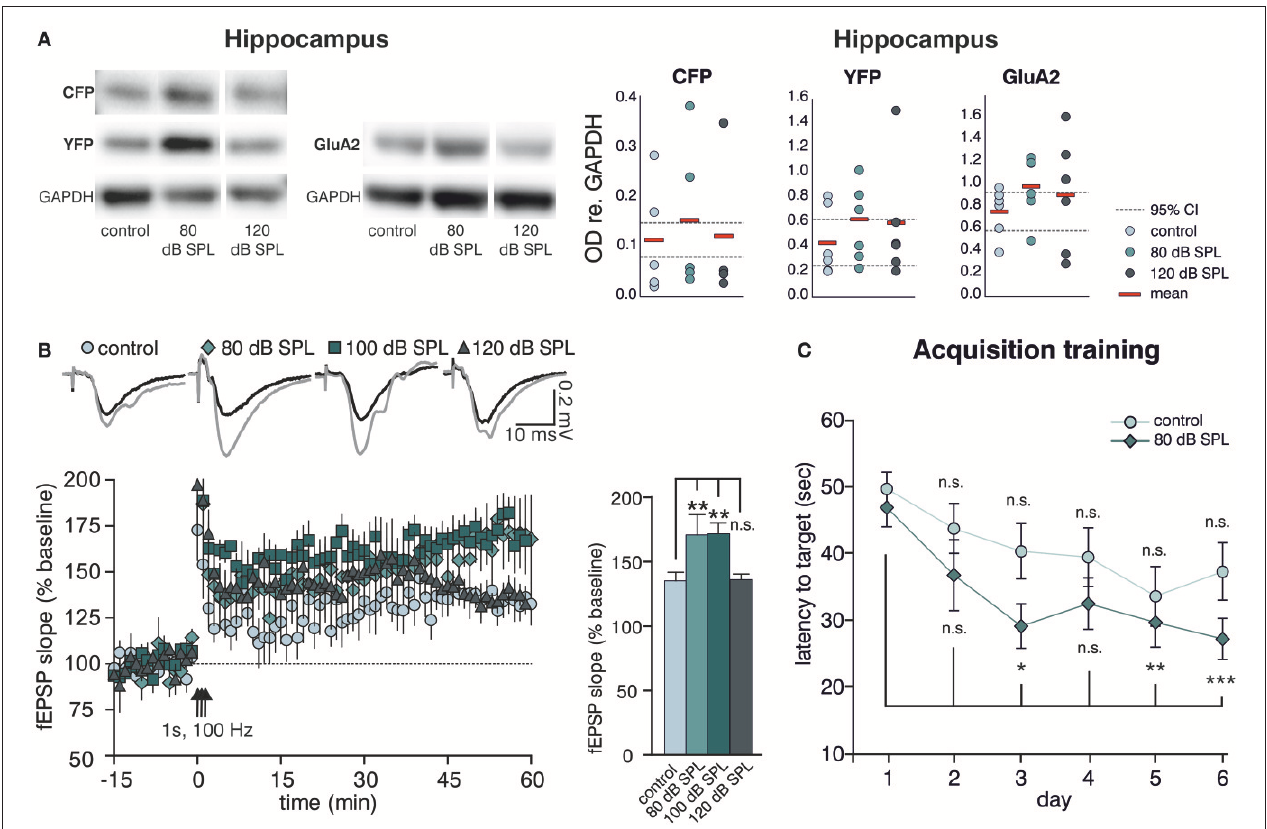
FIGURE 3 | Acoustic enrichment enhances hippocampal BDNF expression and LTP as well as memory acquisition in the Morris water maze (MWM). (A) Left panel: Western blot analysis of Bdnf exon-IV-CFP and exon-VI-YFP (left blot) as well as GluA2 (right blot) in the hippocampus of BLEV reporter mice exposed to sham, 80, or 120 dB SPL. Right panel: Densitometric analyses of Western blots (dots: averaged results per animal, bars: means, dashed lines: 95% confidence interval for the controls; n = 5 mice/group 2–10 Western blots each). For originals see Supplementary Figure 2D. (B) Left Panel: Averaged time courses of fEPSP slopes in acute brain slices from BLEV reporter mice 2 weeks after exposure to sham, 80, 100, or 120 dB SPL. Representative traces before (black) and after (gray) induction of LTP are shown on top. Animals from all conditions readily show significant SC LTP. Right panel: Significantly increased LTP was observed for 80 (171 ± 16% of baseline) and 100 (172 ± 8% of baseline) but not 120 dB SPL (136 ± 4% of baseline) compared to controls (135 ± 7% of baseline). Data are represented as mean ± SEM. (C) Latency to target during acquisition learning. After 3 days mice exposed to 80 dB SPL need less time to find the platform in comparison to the first experimental day than mice in the control group. Data are expressed as mean ±